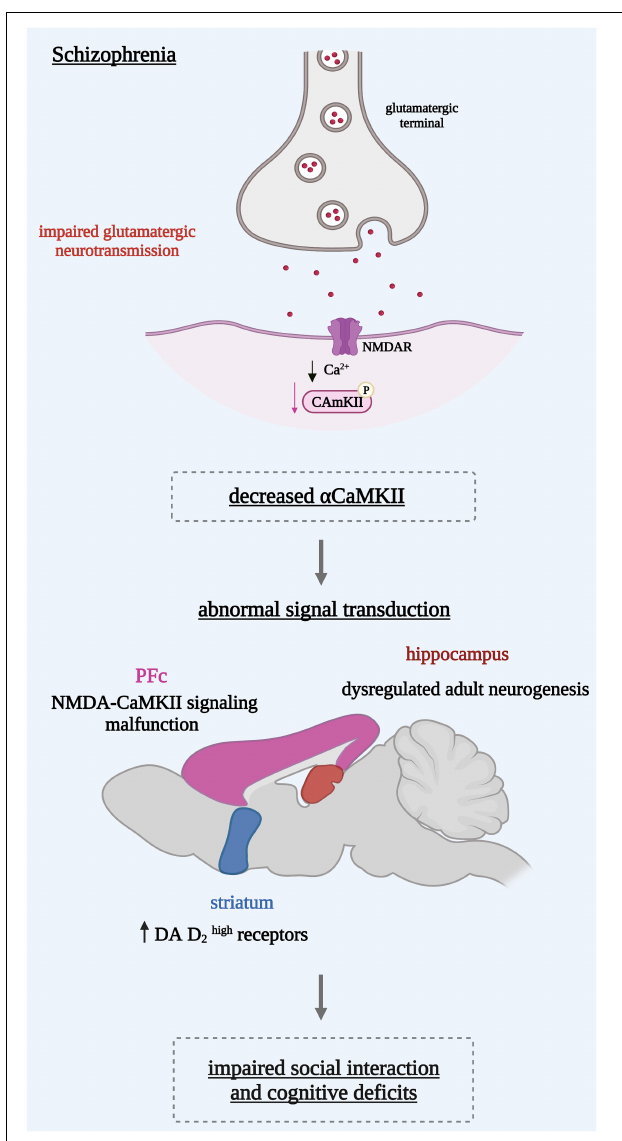
FIGURE 1 | Reduced α -CaMKII induces on the cellular level an abnormal signal transduction reflected in different brain regions. In the hippocampus: a dysregulated adult neurogenesis leading to an immature dentate gyrus in the hippocampus. In the pre-frontal cortex (PFc): a malfunction of NMDA receptor signaling in the associated with dopaminergic hypo-function. In the striatum: dopamine (DA) D2 receptors in a state with a high affinity for DA leading to a hyperdopaminergic state. These mechanisms might underlie behavioral abnormalities such as the social interaction impairments and cognitive deficits seen in